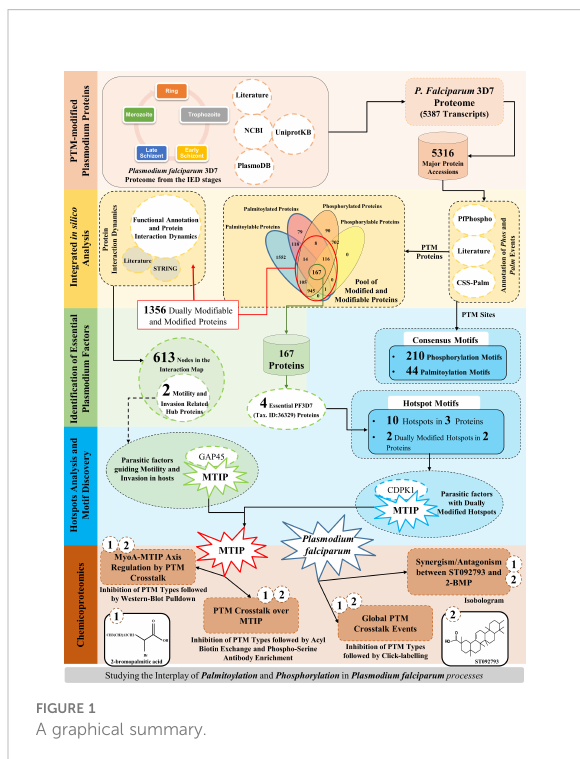
FIGURE 1 A graphical